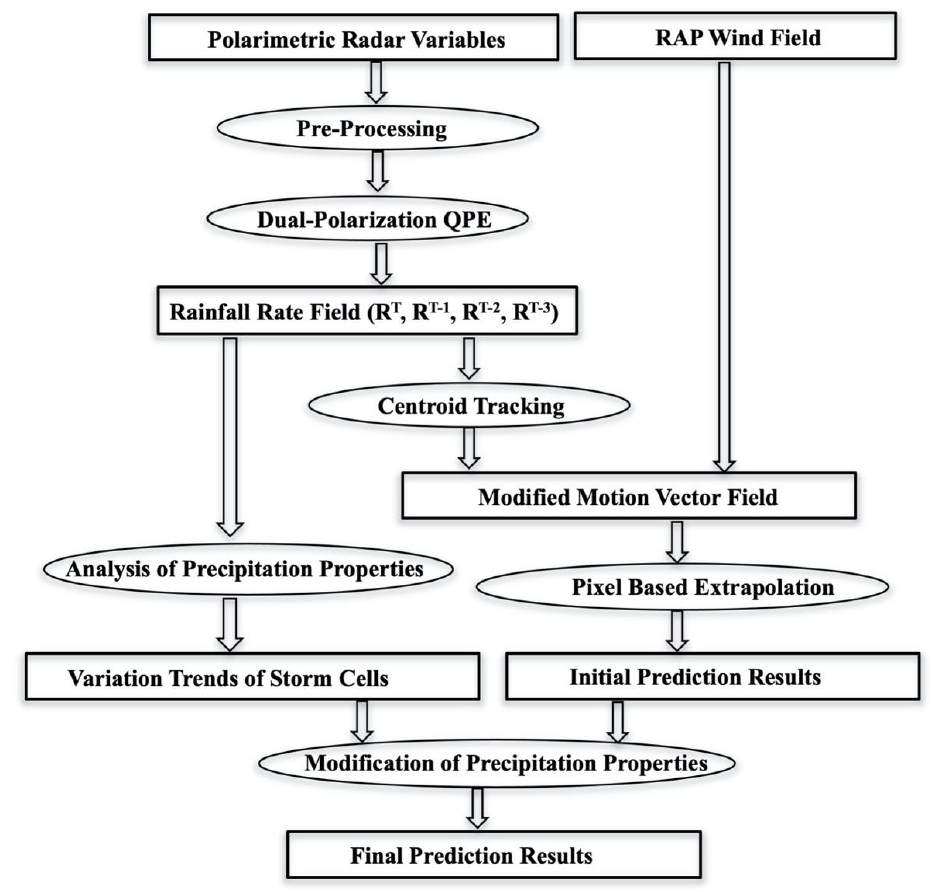
Figure 1. The flow chart of the proposed radar-based QPF approach.